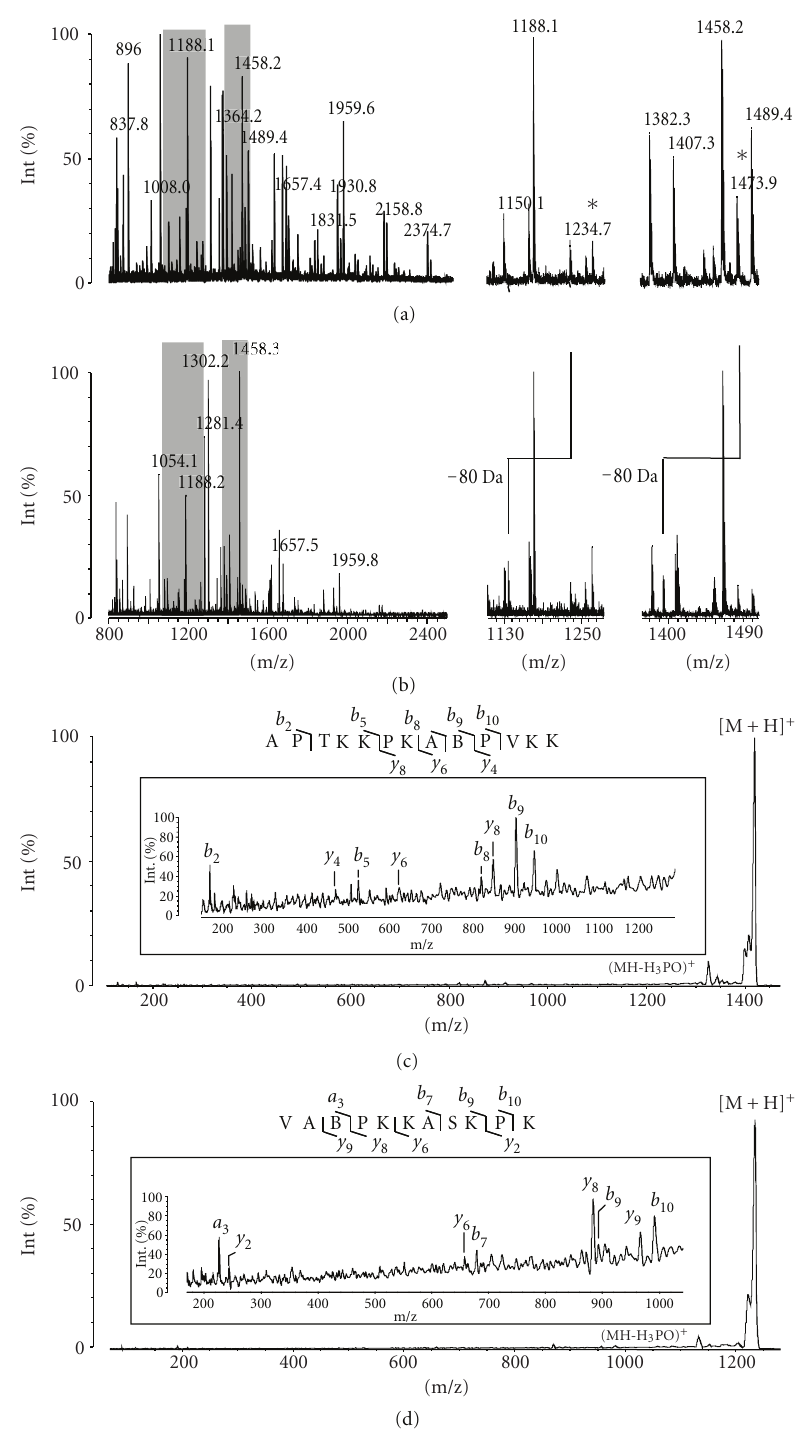
Figure 7: The MALDI MS analysis of phosphopeptides from CDK1-treated human histone H1. MS spectra of the tryptic peptides from CDK1-treated histone H1 with the untreated (Figure 7(a)) and alkaline phosphatase-treated histone H1 (Figure 7(b)). The two panels on the right show the magnified spectra to indicate the two phosphopeptides labeled with asterisks ( ∗ ). The MALDI-TOF/TOF-MS analysis of phosphorylation sites on the two monophosphopeptides VApTPKKASKPK, m/z 1234.7 (c), APTKKPKApTPVKK, m/z 1473.9 (d) from the CDK1-treated human histone H1. The neutral-loss peak of phosphopeptide was noted as [MH-H 3 PO 4 ] + . The fragment patterns of peptides were shown in the magnified MS/MS spectra. “B” in the amino sequence indicates a dehydroamino-2-butyric acid residue converted from a phosphothreonine residue by beta-elimination of H 3 PO 4 . All the spectra were detected using DHAP/DAHC matrix in the positive